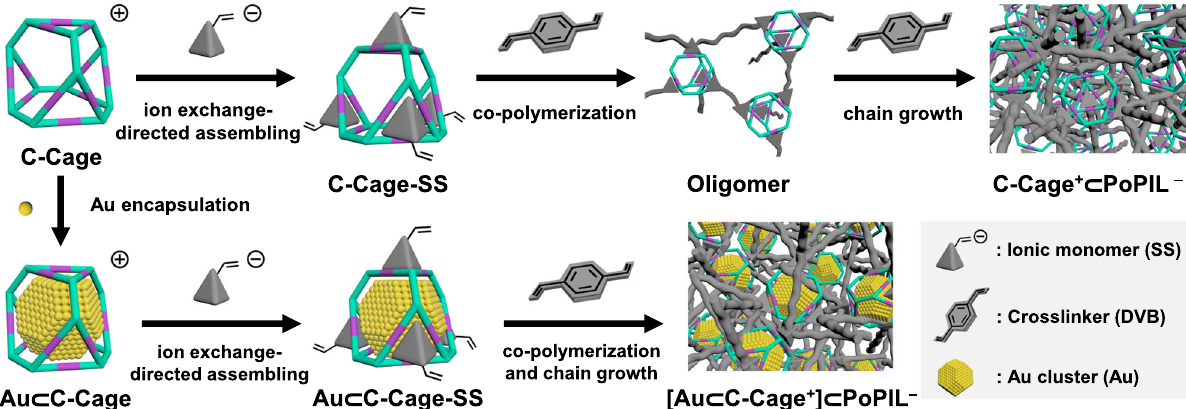
Fig. 1 Schematic of the synthetic methodology for the hierarchical host-in-host cationic cage-porous poly(ionic liquid) (C-Cage + ⊂ PoPIL − ) composites. Note: C-Cage and 4-styrenesulfonate (SS) counteranion are selected as the representatives. Each C-Cage has 12 + charge and 12 counteranion, here, only one cation is displayed and the counteranions are not shown for the sake of